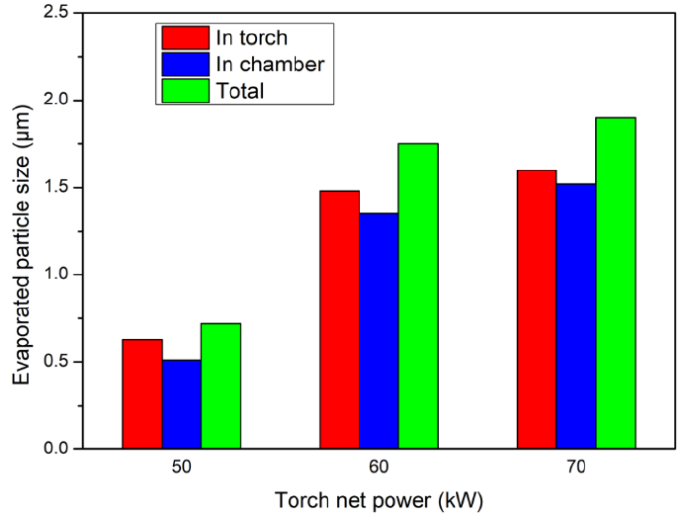
Figure 14. Effect of the torch net power on the size of the fully evaporated YSZ particles in the torch, free jet and in total. 60. SLPM of argon, 30 SLPM of helium, chamber pressure: 100